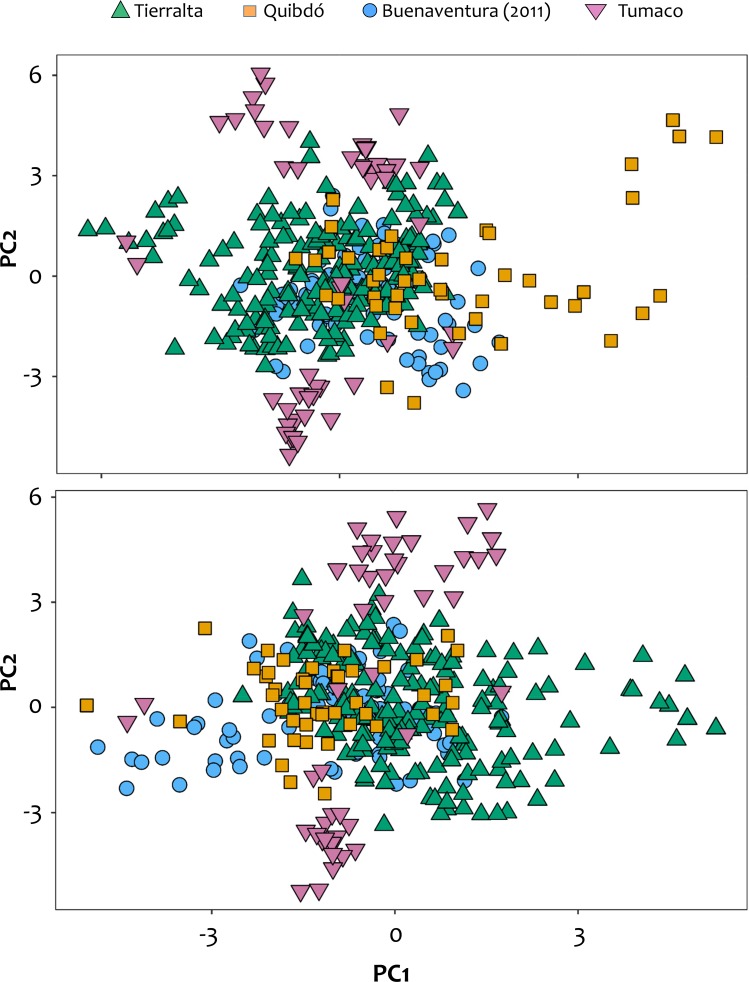
PCA with alleles with absolute frequency ≤ 5 (top) and ≤ 10 removed (bottom). Results are almost identical; only the sign of the axes is reversed.